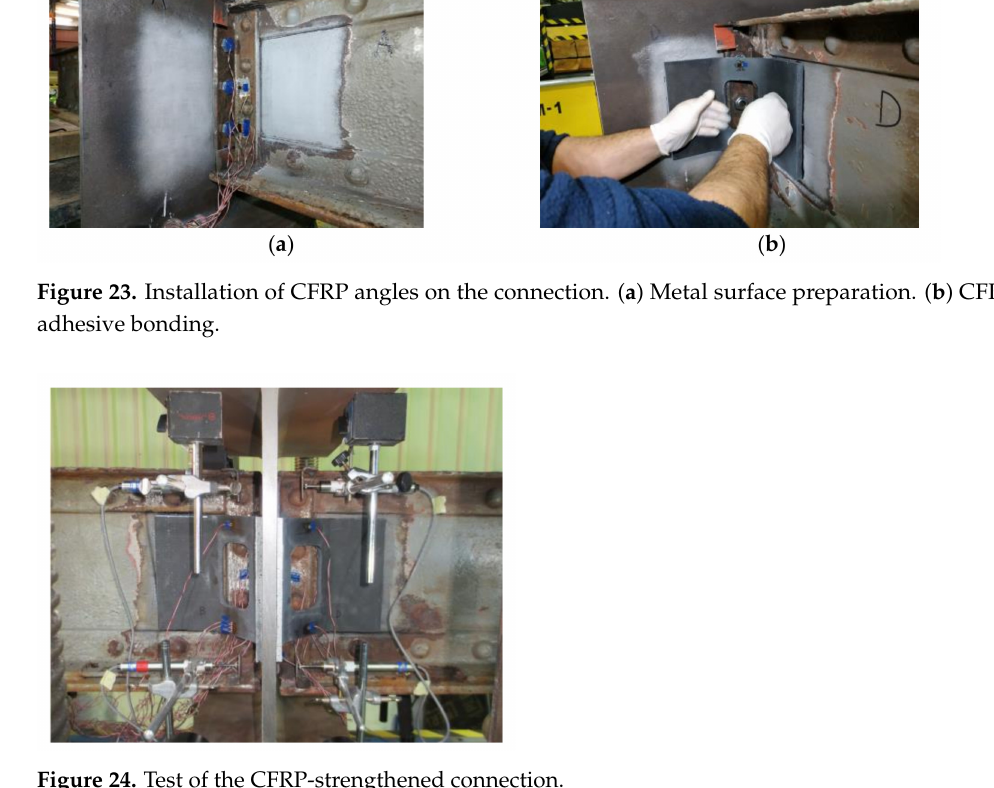
Figure 24. Test of the CFRP-strengthened